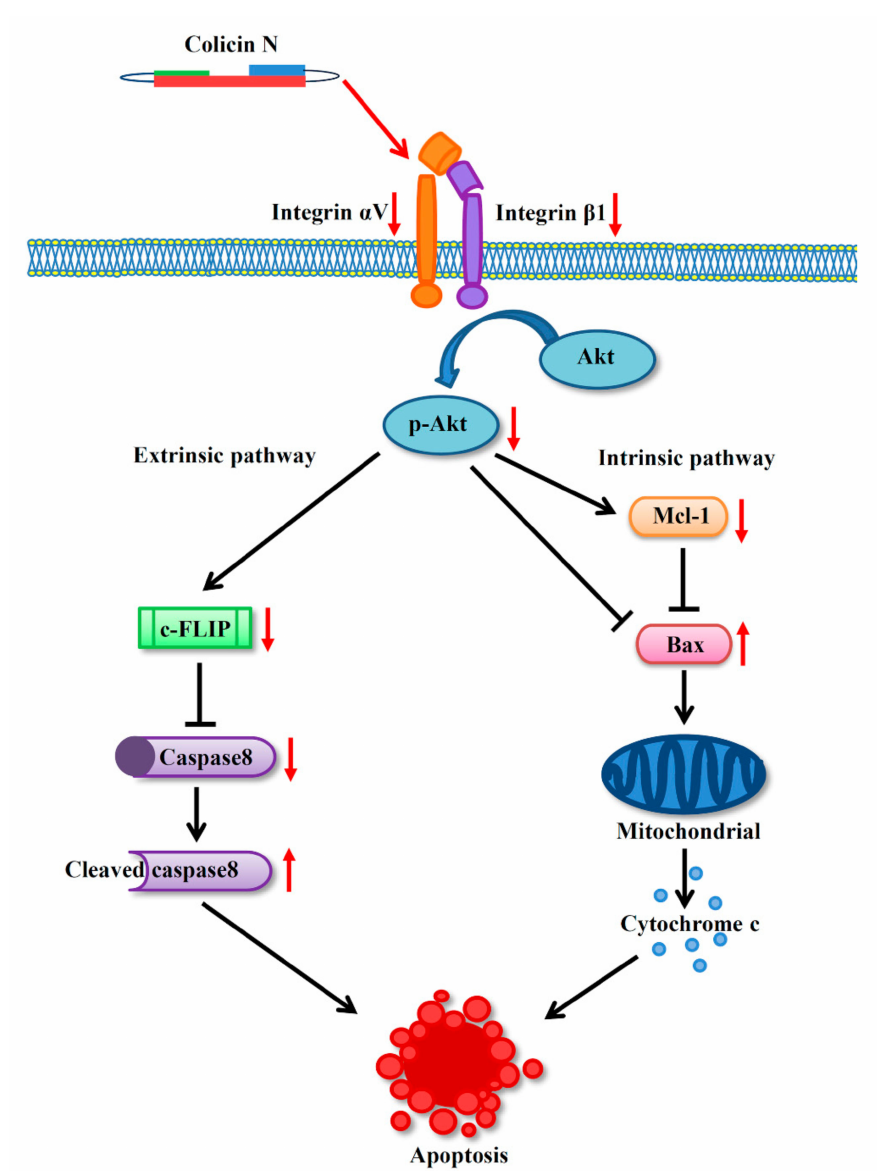
Figure 6. Considering its e ff ect on down-regulation of integrin β 1 and α V, colicin N modulates integrin signaling necessary for cell survival evidenced with the decrease in p-Akt, which is the active form of the master survival regulator, Akt. This event shifts the cells towards activation of extrinsic and intrinsic apoptosis by alteration of c-FLIP and the Bcl-2 family proteins (Mcl-1 and Bax),